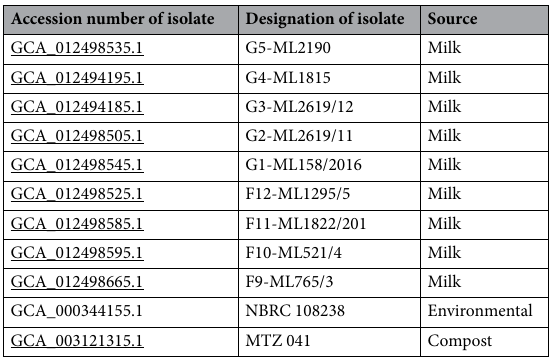
Table 5. The GenBank assembly accessions number of selected isolates of Gordonia